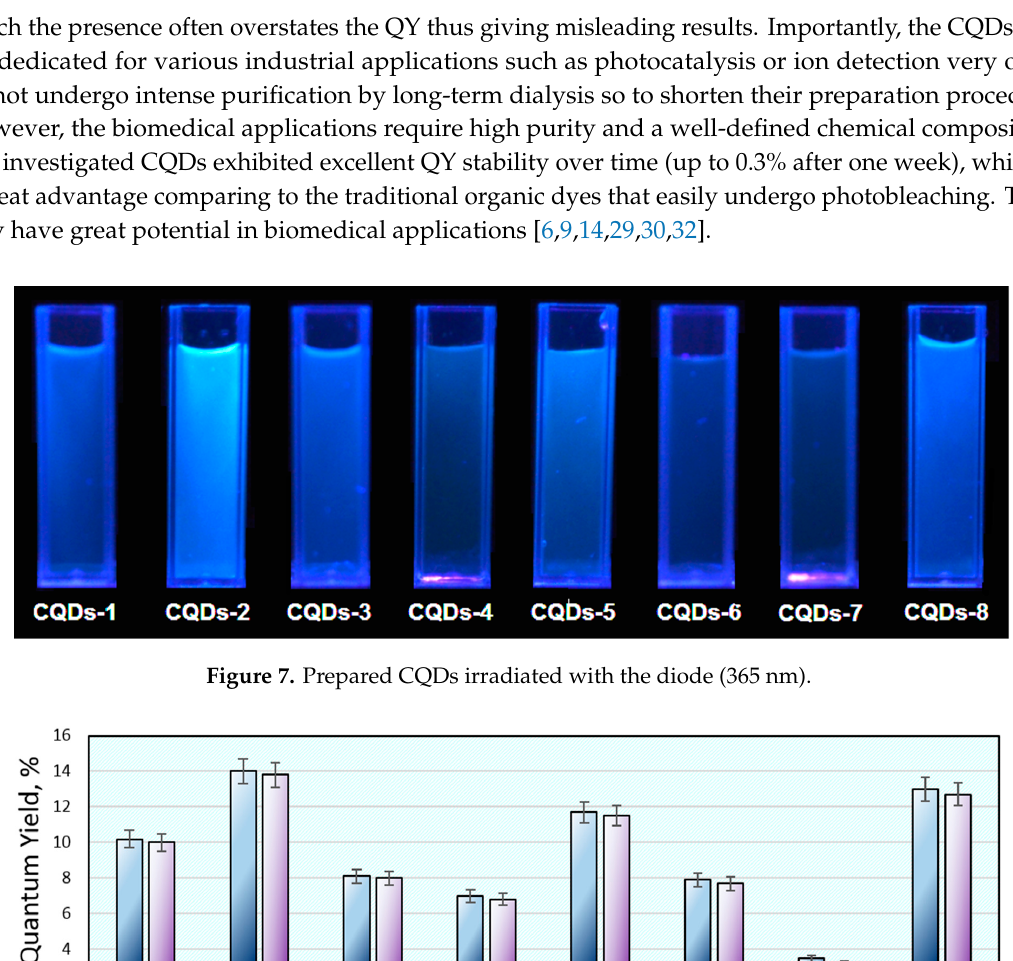
Figure 8. Quantum yield of the prepared samples and its stability after 7 days.